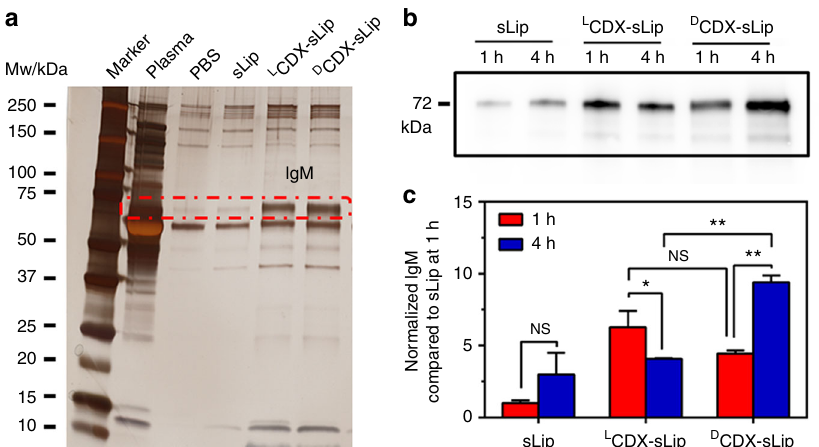
Fig. 4 Effect of the modi fi ed peptides on the composition of protein corona. a Separation of protein corona by SDS-PAGE. IgM (at Mw 72 kDa, circled in the red dashed line) was characterized by nano-LC-MS/MS. b Western blot assay of natural IgM on liposomal surface in vivo 1 and 4 h after injection. c Quanti fi cation of absorbed natural IgM by normalizing the gray values. n = 3, data are means ± s.d. Statistical signi fi cances were calculated by Student ’ s t -test. NS indicates not signi fi cant, * p < 0.05, ** p < 0.01